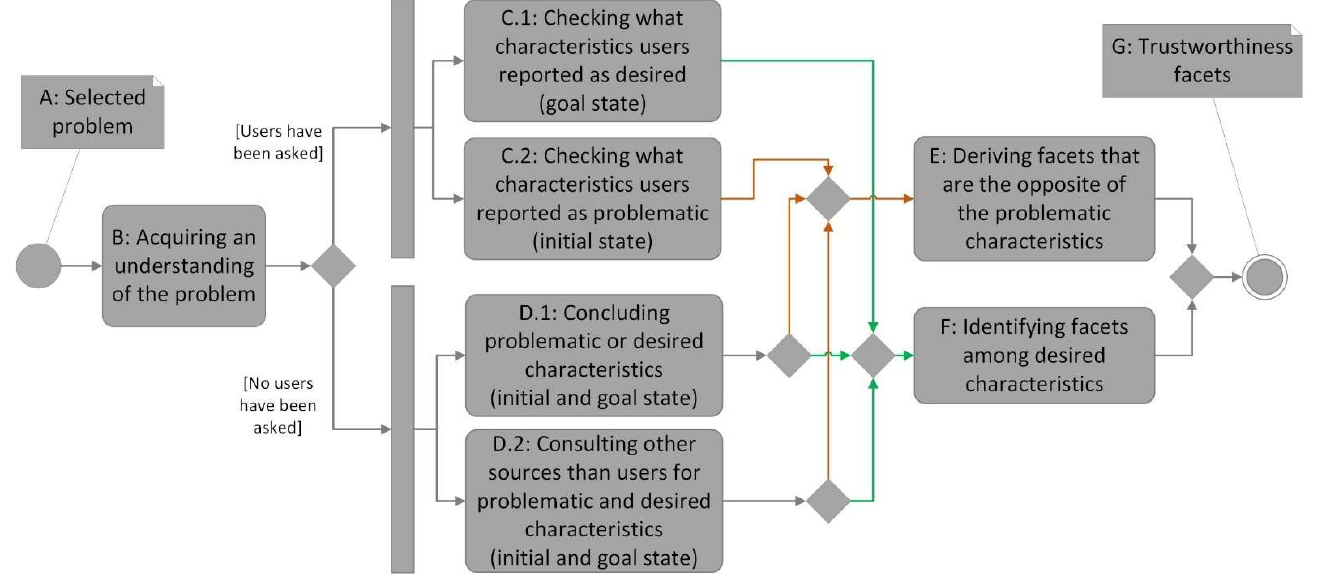
Figure 2. Guideline for identifying trustworthiness facets. Orange arrows point out the identification of problematic characteristics. Green arrows represent the paths for the identification of desired characteristics.